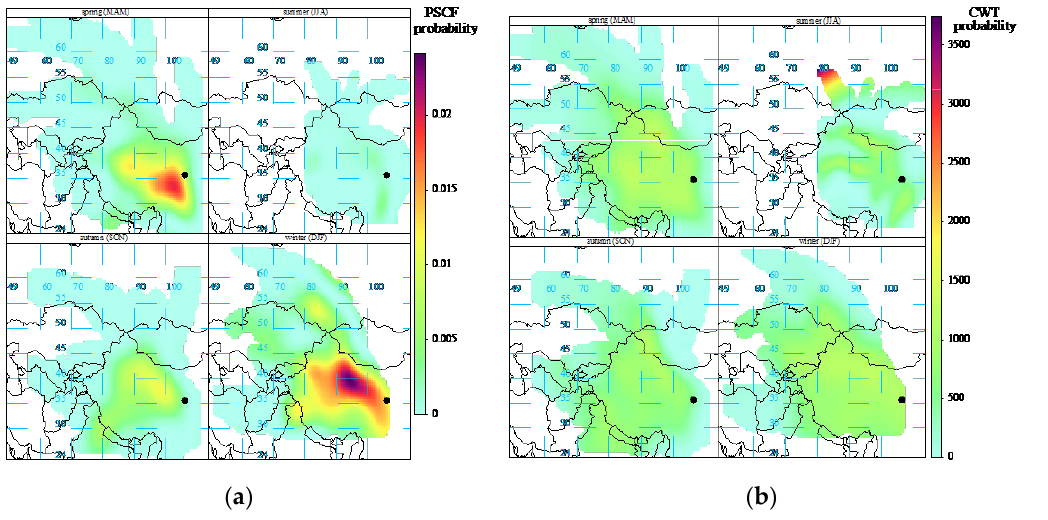
Figure 11. The analysis of potential sources using the ( a ) PSCF and ( b ) CWT approaches of CCN from August 2020 to November 2021.